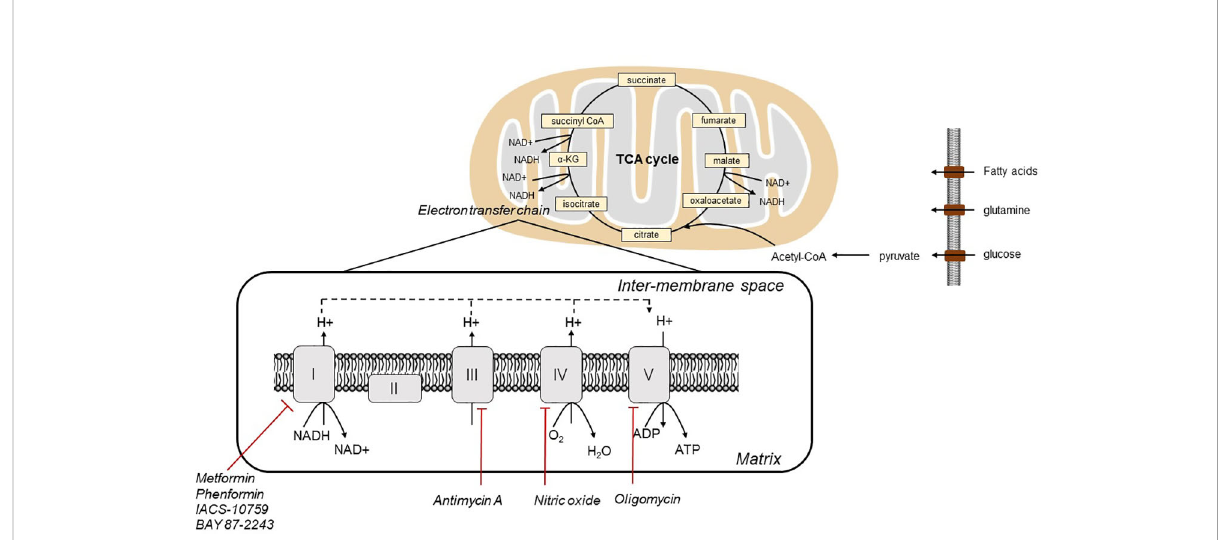
FIGURE 1 Illustration of mitochondrial electron transport, oxygen consumption and OXPHOS in